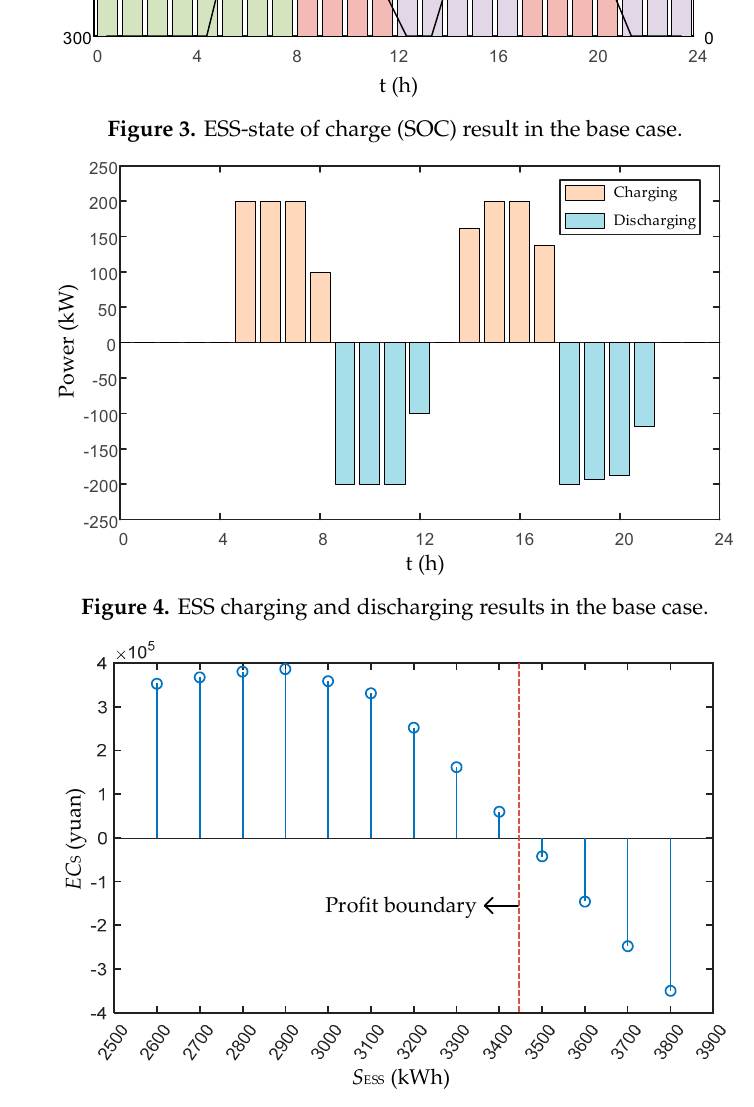
Figure 5. EC S (static investment economic criterion) values with different ESS capacity deployments.